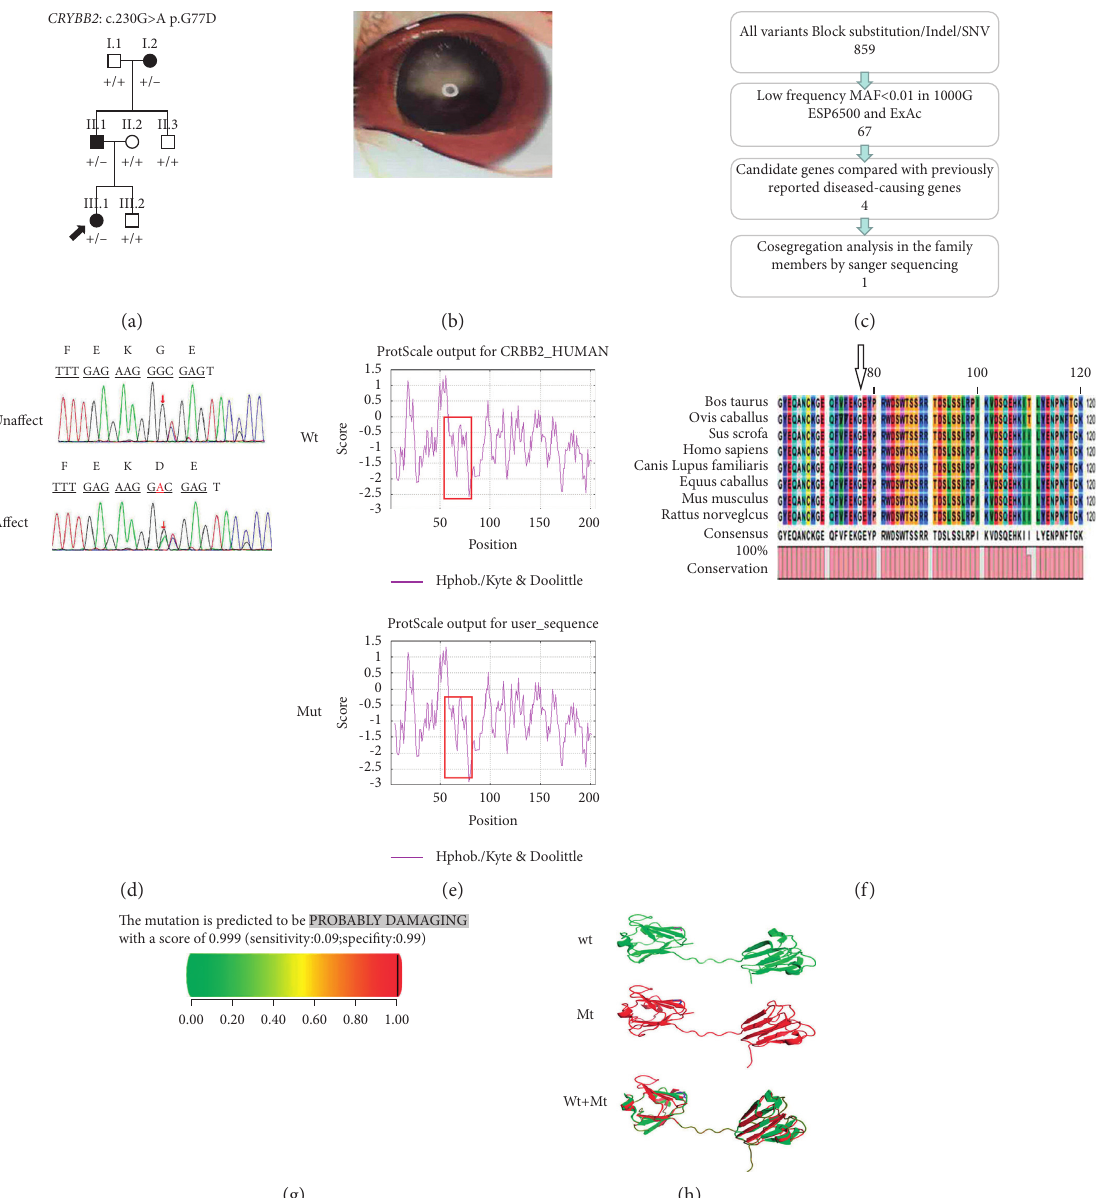
Figure 2: (a) Pedigree of ADCC family B The solid black arrow indicates the proband (III.1). (b) A photograph of the proband’s (III.1) lens is shown. (c) Schematic representation of the filter strategies employed in our study. (d) Sanger sequencing results. (e) hydropathic characteristics caused by changes in the variant protein. (f) Multiple protein sequence alignment. (g) The score obtained from PolyPhen-2 analysis was 0.999. (h) The structures of the homomeric WTand variant CRYBB2 : c.230G > A; p.G77D proteins were modelled in